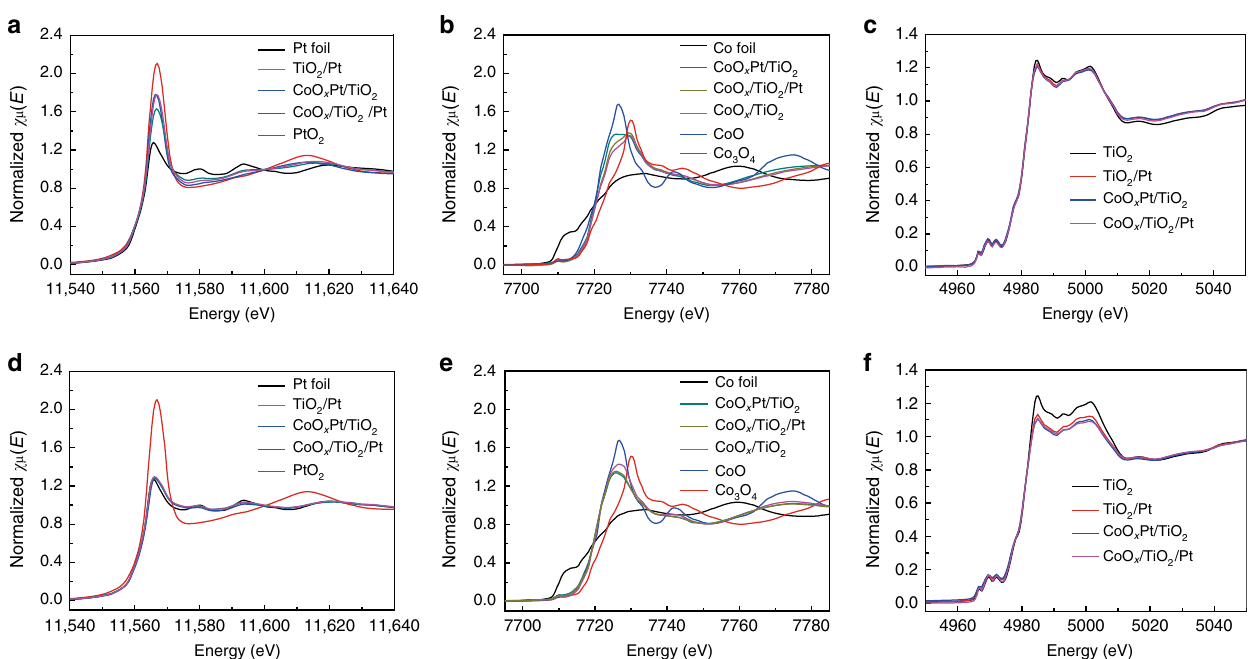
Fig. 3 XANES spectra of the catalysts. a Ex situ and d in situ Pt L 3 -edge XANES spectra of TiO 2 /Pt, CoO x /TiO 2 /Pt, CoO x Pt/TiO 2 , and reference Pt foil and PtO 2 ; b Ex situ and e in situ Co K-edge XANES spectra of TiO 2 /Pt, CoO x /TiO 2 /Pt, CoO x Pt/TiO 2 , and reference Co foil, CoO and Co 3 O 4 ; c Ex situ and f in situ Ti K-edge XANES spectra of TiO 2 /Pt, CoO x Pt/TiO 2 , CoO x /TiO 2 /Pt and reference TiO